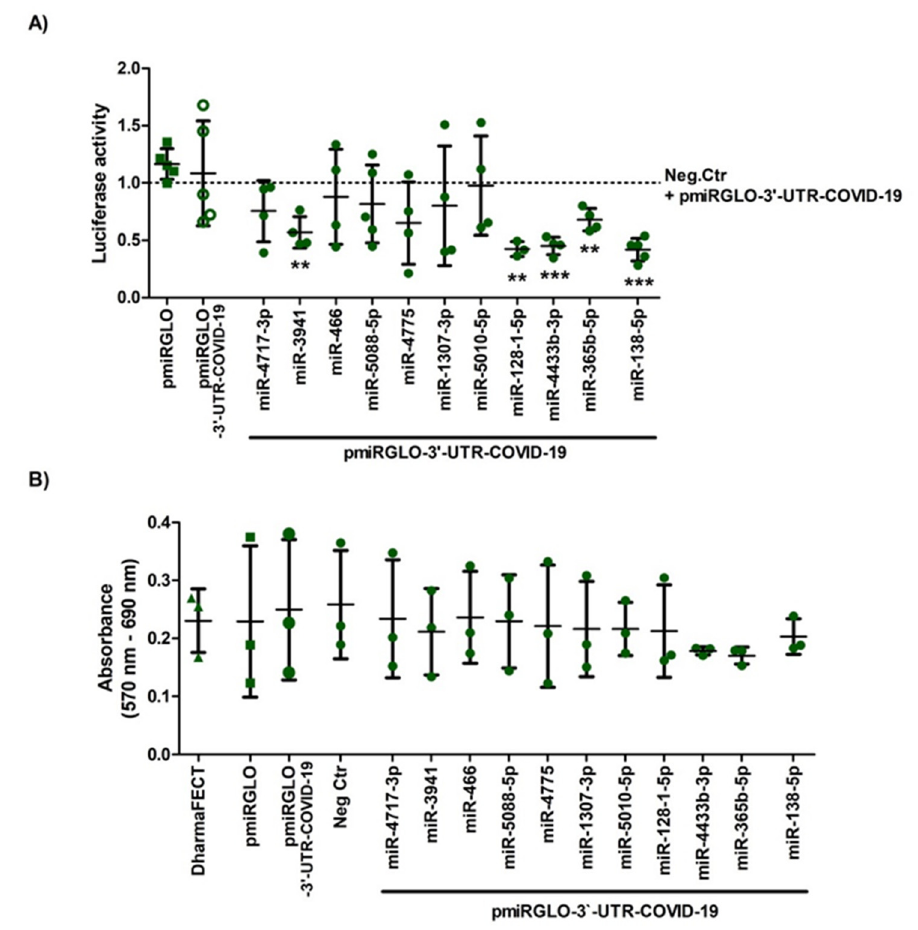
Figure 3. Regulation of pmiRGLO-3 (cid:48) -UTR-COVID-19 plasmid expression by selected microRNAs in HEK293T cells and cell viability after transfection. Cells were transiently co-transfected with control or reporter constructs and selected microRNA mimics or the negative control microRNA. ( A ) Firefly/Renilla luminescence ratio showed that hsa-miR-3941, hsa-miR-128-1-5p, hsa-miR-4433b-3p, and hsa-miR-365b-5p, as well as hsa-miR-138-5p, significant decreased the expression of pmiRGLO-3 (cid:48) -UTR-COVID-19 related to the expression of negative control mimic (paired Student’s t test, one-tailed p -value < 0.05 after Bonferroni correction). ** indicates a p -value < 0.01 and *** p -value < 0.001; ( B ) On the other hand, MTT assay data showed that empty pmiRGLO or pmiRGLO-3 (cid:48) -UTR-COVID-19 plasmids and mimics did not produce any significant cytotoxic effect related to DharmaFECT after 24 h of co-transfection (paired Student’s t test). Graph represents the mean ± SD of, at least, three experiments. An extended figure with all experimental replicate data points is available in Figure S1.